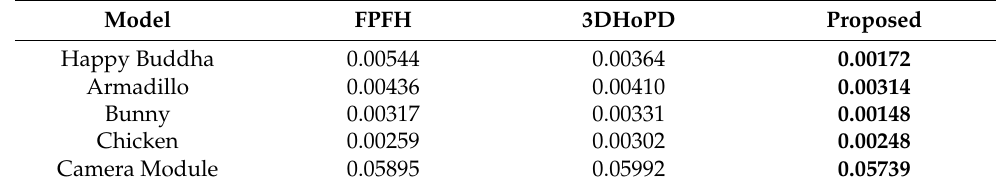
Table 4. Registration errors of five models.